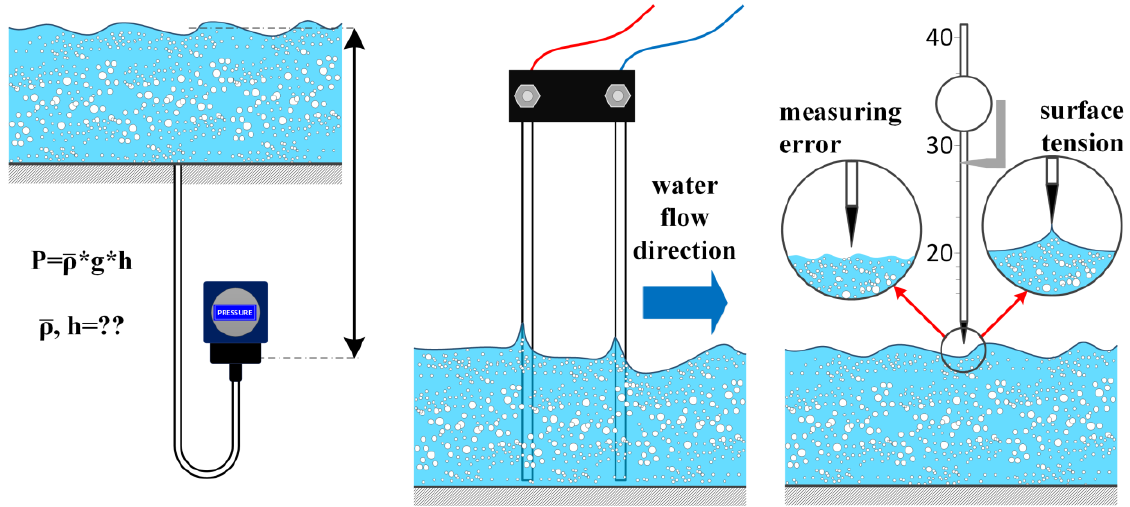
Figure 1. Principle of operation of manometers ( left ), wave probes ( middle ) and point gauge ( right ), with common issues found.